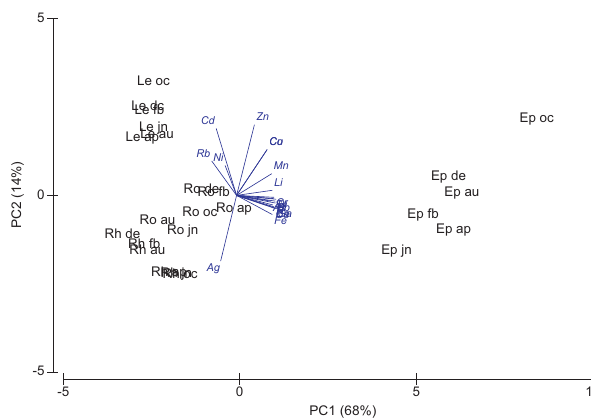
Fig. 2. Principal component analysis (PCA) of P. oceanica compart- ments for each sampling event based on element concentrations. Le: leaves; Rh: rhizomes; Ro: roots; Ep: epiphytes; jn: June 2006; au: August 2006; oc: October 2006; de: December 2006; fb: February 2007; ap: April 2007. Note that the names of some trace elements are plotted very close to each other, this is the case of Co and Cu; and As, Ba, Bi, Cr, Cs, Fe, Ga, Pb, Sr, Tl, and V.